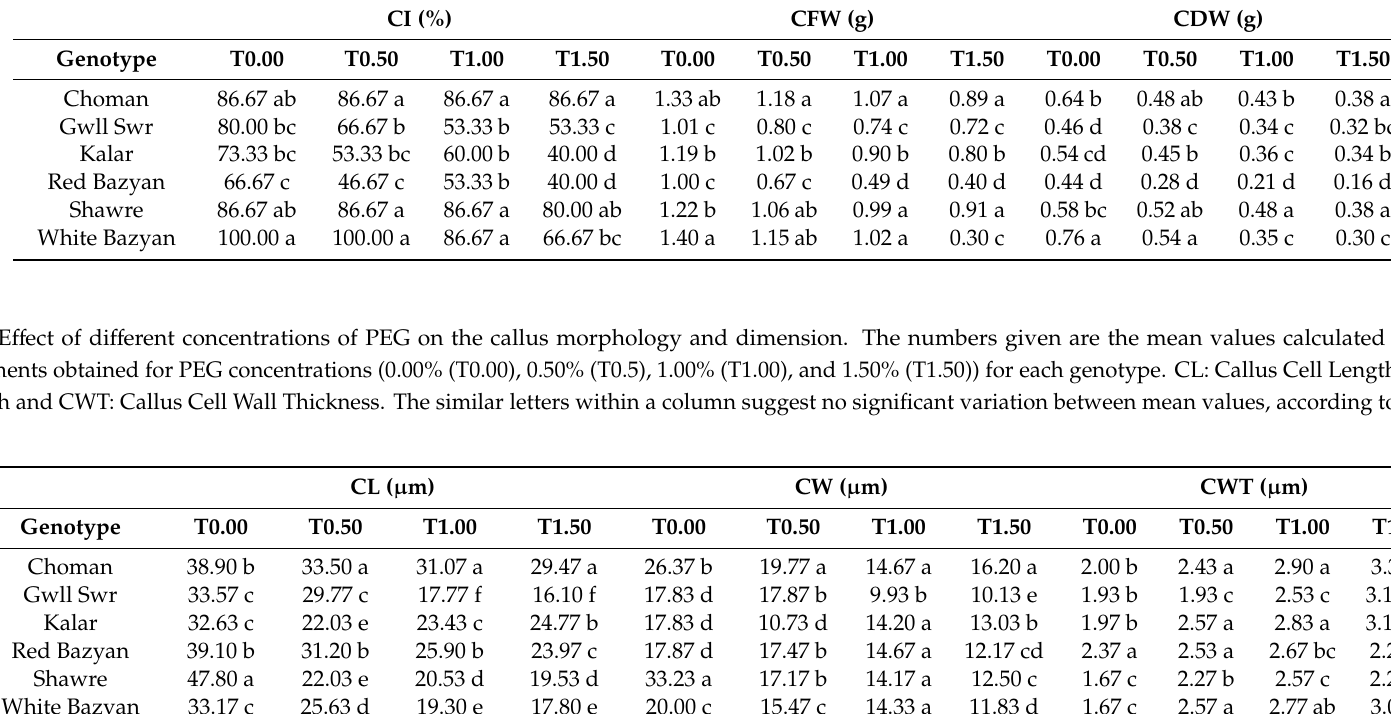
Table 4. Impact of PEG concentrations on the callus growth parameters in rice genotypes. The statistics provided are the mean values measured for the three measures collected over PEG concentrations (0.00% (T0.00), 0.50% (T0.50), 1.00% (T1.00), and 1.50% (T1.50)) for each genotype. CI: Callus Induction, CFW: Callus Fresh Weight, CDW: and Callus Dry Weight. The common letters within a column suggest no major variation between mean values, according to Duncan’s Multiple Range Test ( p ≤ 0.05). CI (%) CFW (g) CDW (g) Genotype T0.00 T0.50 T1.00 T1.50 T0.00 T0.50 T1.00